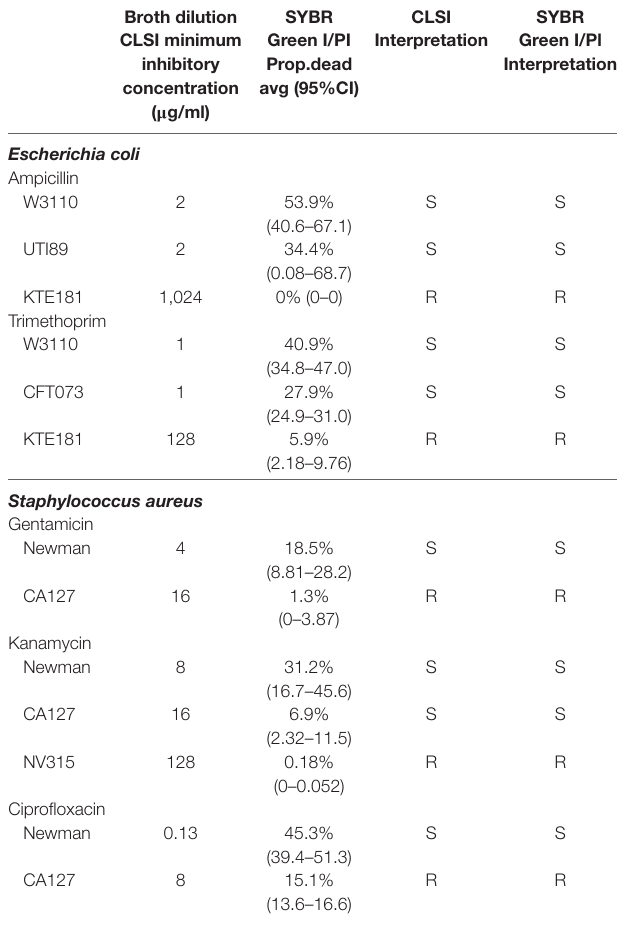
TaBle 1 | Summary of broth dilution results and SYBR Green I/propidium iodide (PI) assay.